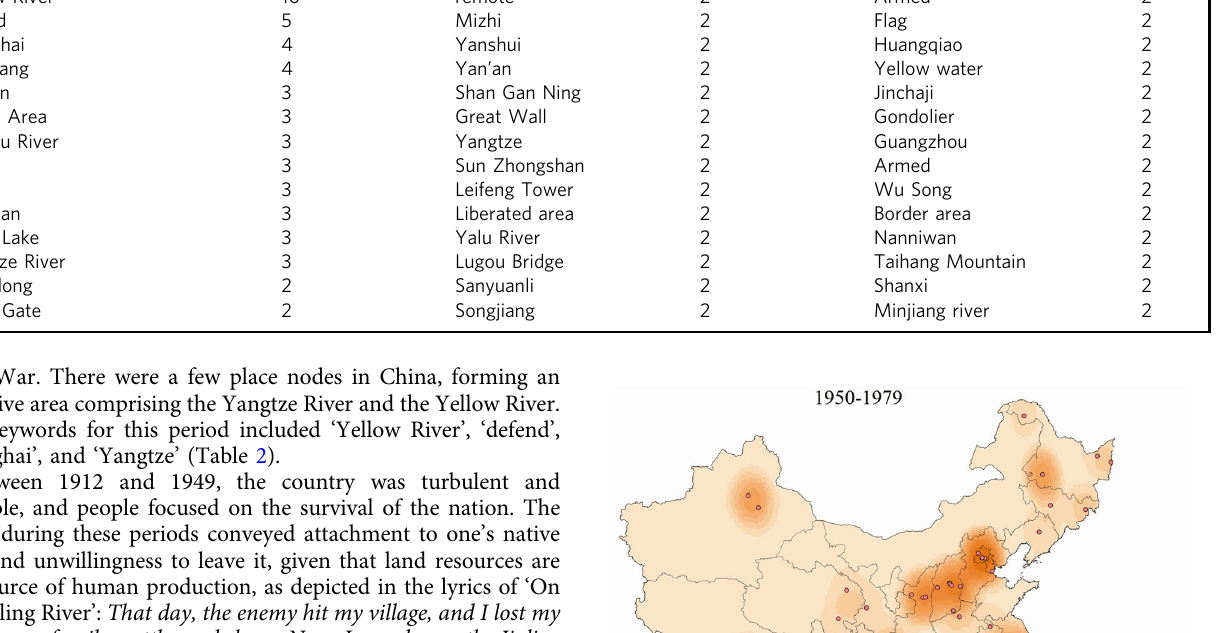
Table 2 Keywords of sense of place: 1912 – 1949. Key words TF-IDF Key words Key words Yellow River